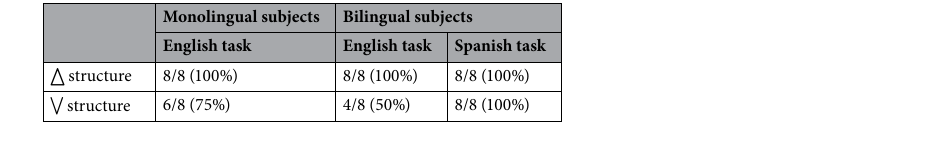
Table 1. Frequency ( f i ) of each structure